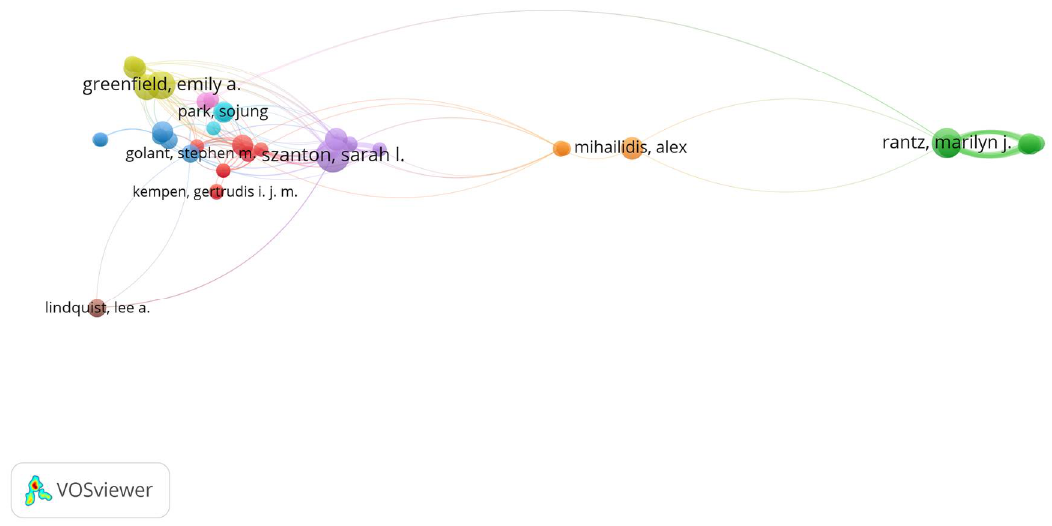
Figure 3. Network visualization of highly productive